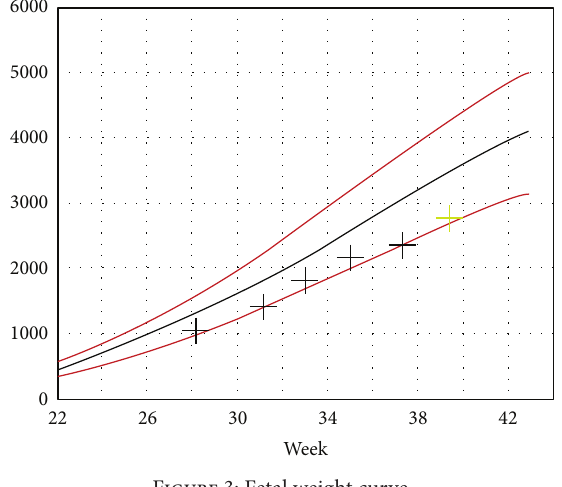
Figure 3: Fetal weight